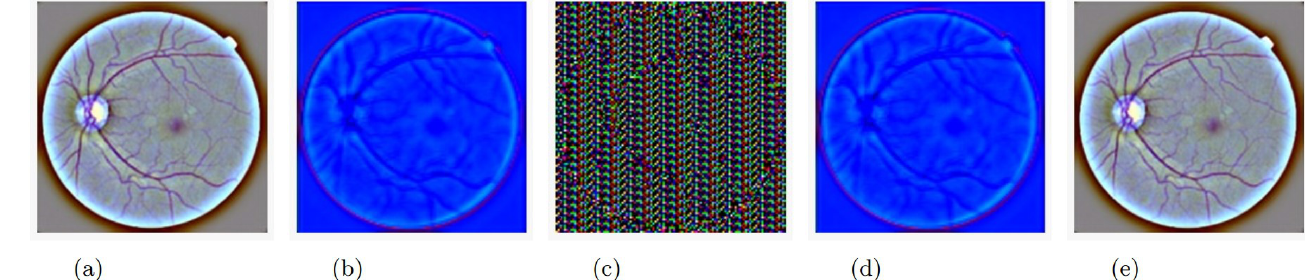
Figure 6. The image changes during its journey from receiver to sender: ( a ) original image, ( b ) image outputted from the encoder (sender’s side), ( c ) image after encryption (sender’s side), ( d ) image after decryption (receiver’s side), ( e ) image outputted from the decoder (receiver’s